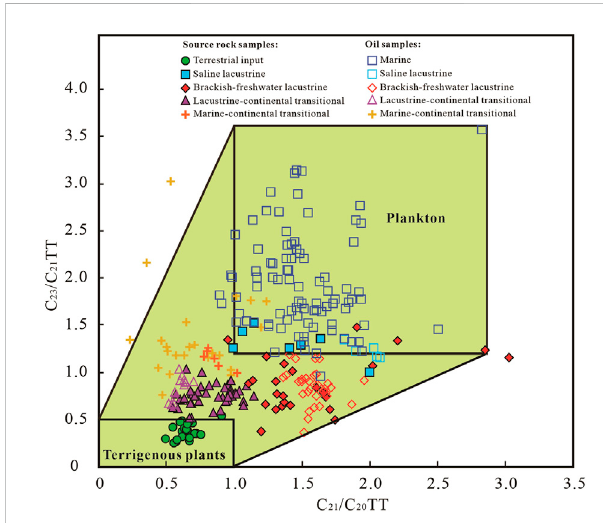
FIGURE 6 Tectonicunitsandcompositestratigraphiccolumnarsectionofthe Ordos Basin (modi fi ed from Li et al., 2021). The samples were collected from the Yishan Slope with the ages ranging from the Ordovician to